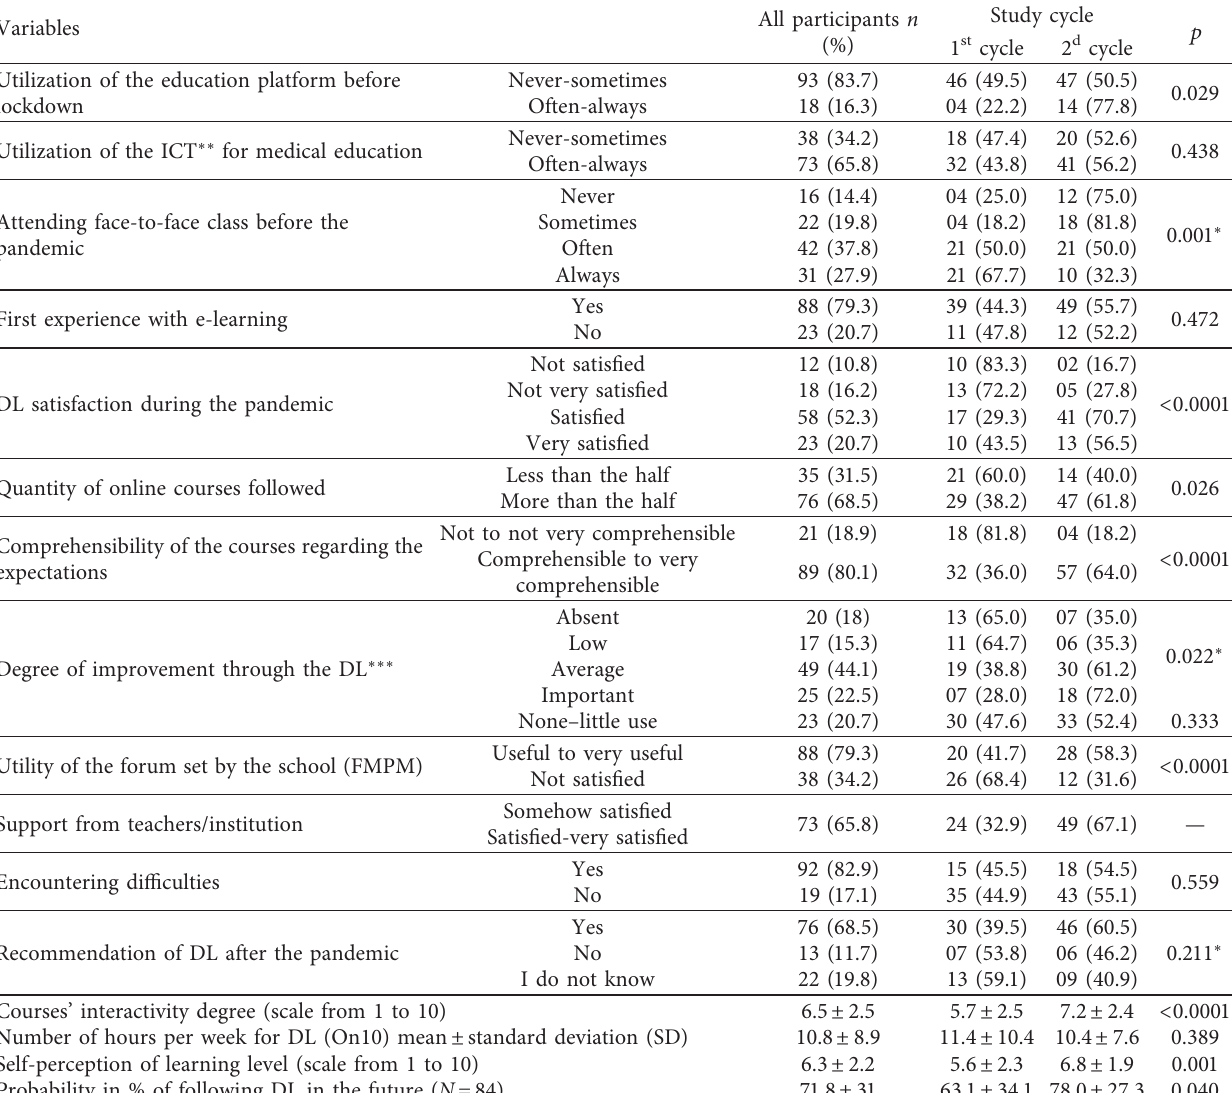
Table 2: The students ‘perceptions of the distance learning during the lockdown and their utilization of the educational platform.